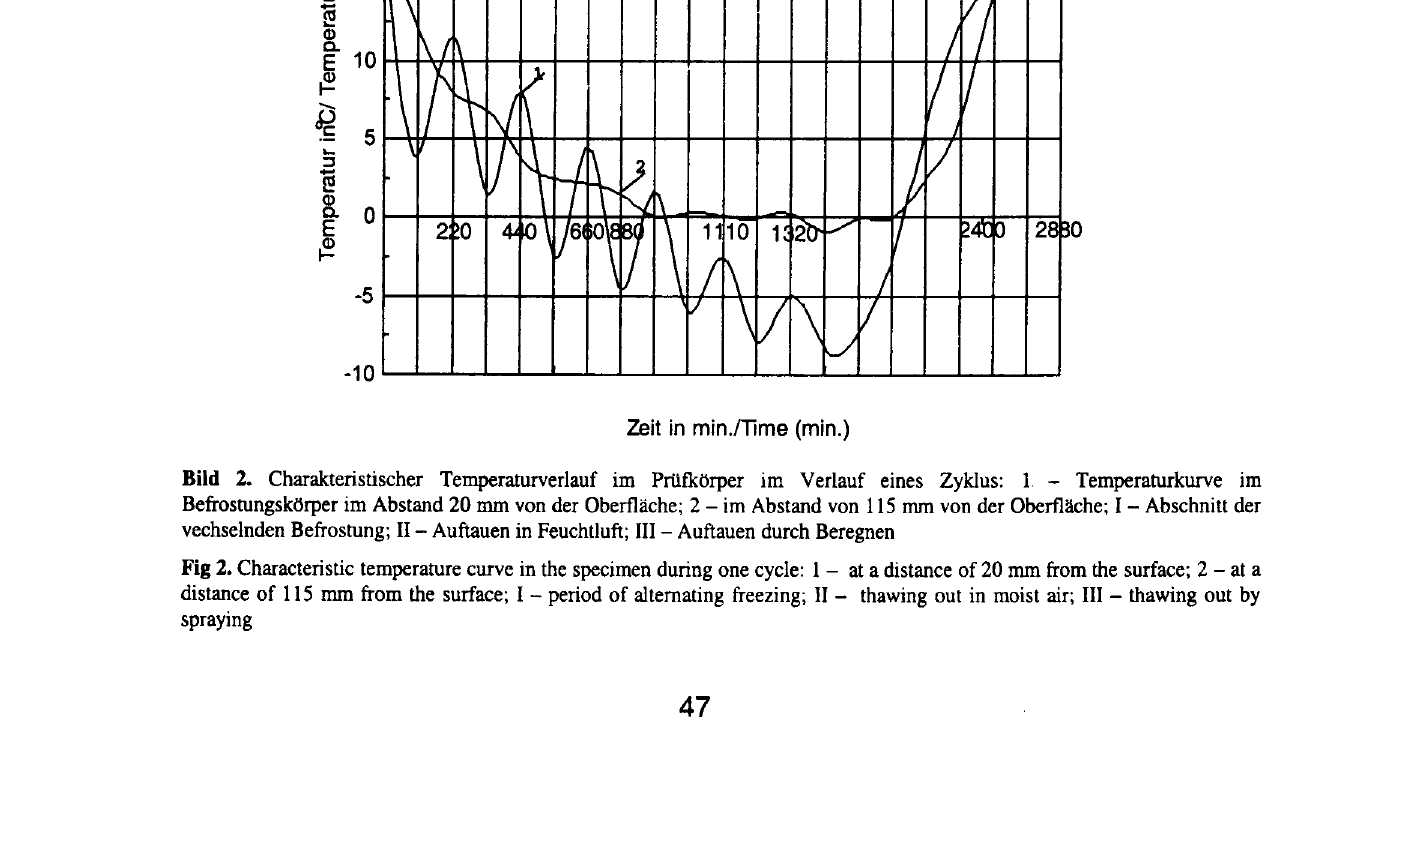
Fig 1. Diagram showing the operating principle of freezing and spraying plant type KhDU-2: I - control section; 2 - freezing chamber; 3 - specimen; 4 - defreezing device with spraying system